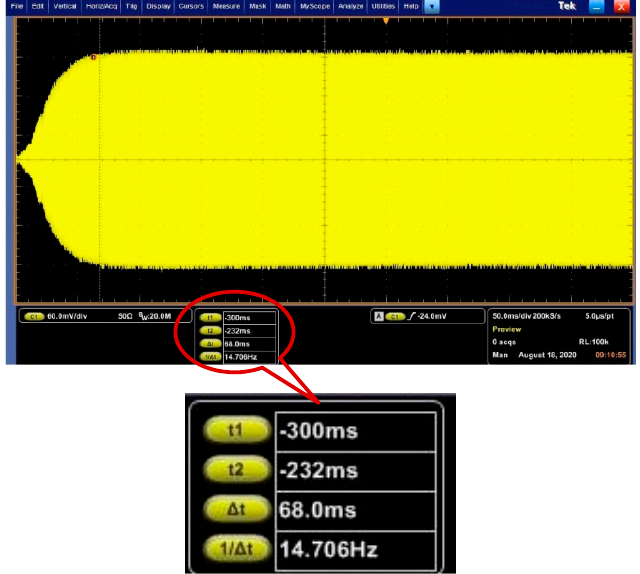
Figure 10. Start-up waveform of AGC loop with DRG experimental Figure 10. Start ‐ up waveform of AGC loop with DRG experimental board.